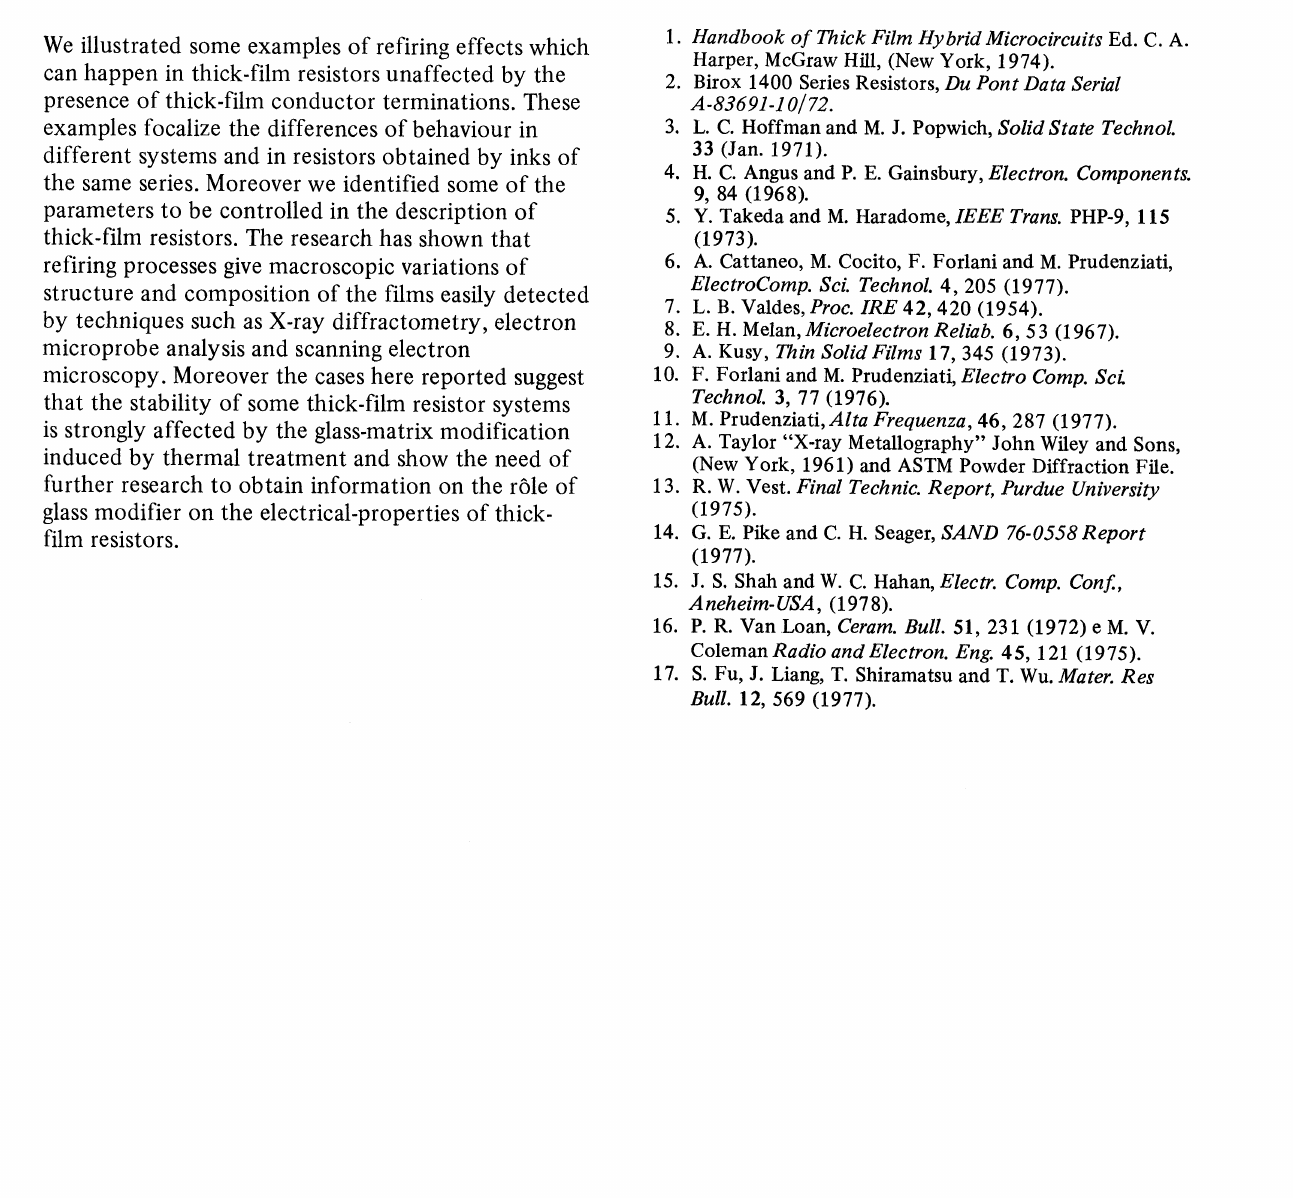
(a) (b) FIGURE 8 SEM pictures of 100 kohm/q Plessey SRD resistors after (a) and (b) 10 firing